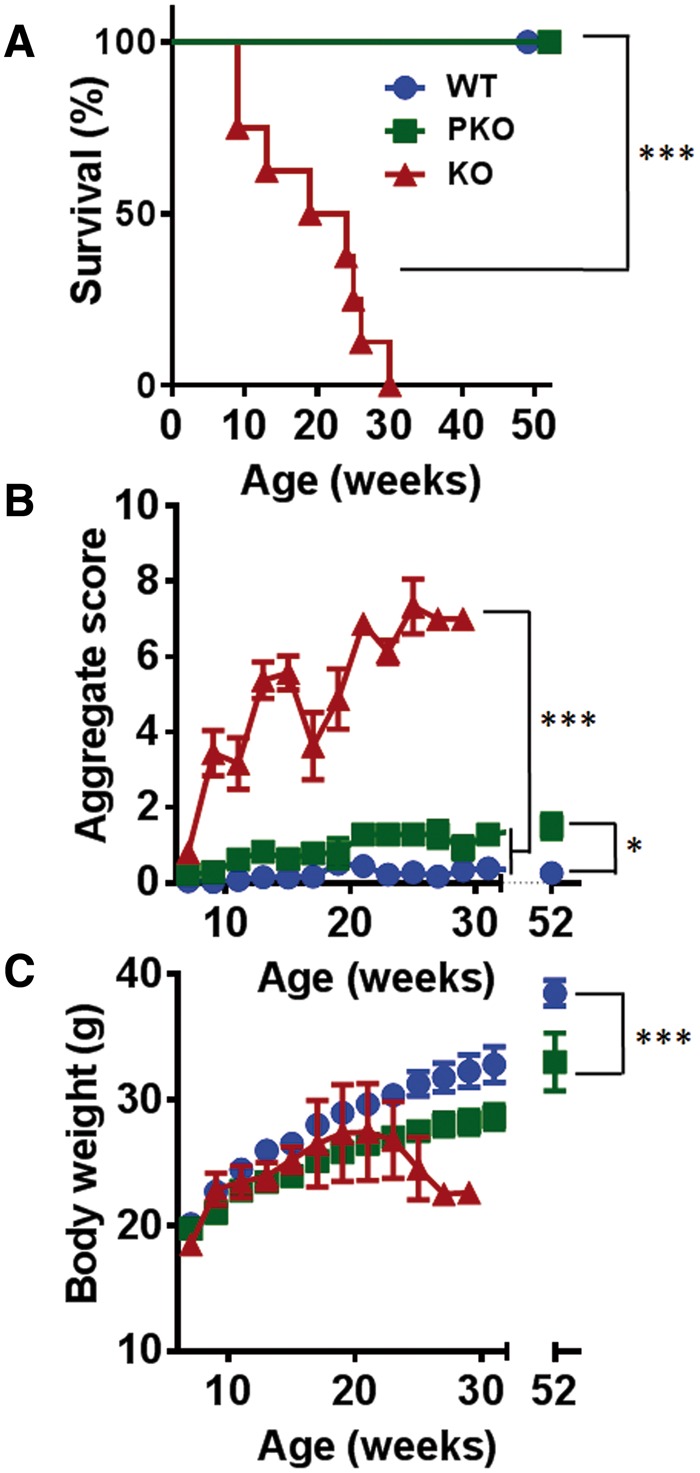
Normal survival and absence of RTT-like signs in peripheral KO mice. (A) Survival plot showing normal survival of WT (blue circles, n = 17) and PKO mice (green squares, n = 7) compared to reduced lifespan in KO mice (red triangles, n = 8). The median survival period was significantly reduced in KO mice (***P < 0.001, log-rank test). (B) Plot showing aggregate phenotype severity (mean ± SEM) based on an established observational scoring system. There was a highly significant difference in score between WT and PKO animals from 8 weeks onwards when compared to KO (***P < 0.001, Kruskal-Wallis test with Dunn’s post hoc analysis). No significant difference was seen between WT and PKO at the time of behavioural testing (15 weeks) but these groups differed significantly at 1 year (*P < 0.05). (C) Plot showing body weight changes over time (mean ± SEM). No significant differences were seen between genotypes at the time of behavioural testing (15 weeks; P > 0.05, one-way ANOVA) but PKO mice had significantly lower bodyweight than WT mice when compared at 1 year (***P < 0.001, student’s unpaired t-test). In B) and C) group sizes at the start of the experiment are as given in A).